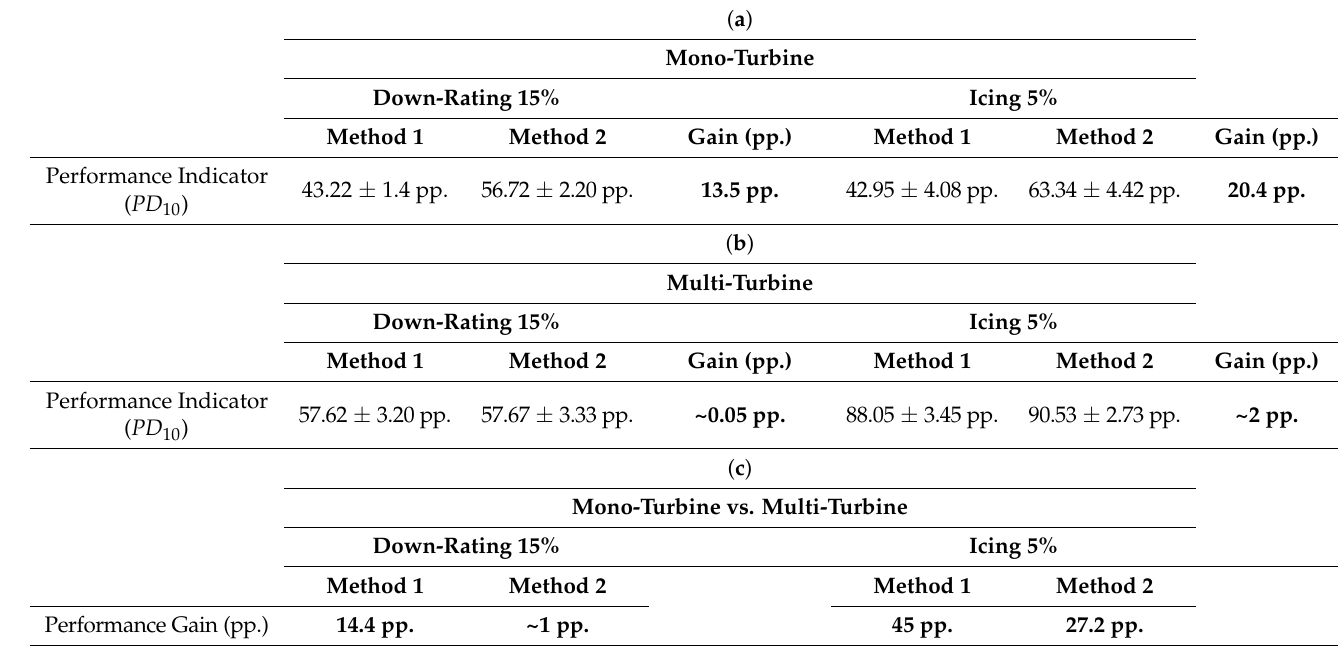
Table 2. ( a ). Performance comparison of Method 1 vs Method 2— Mono-Turbine config . ( b ). Per- formance comparison of Method 1 vs Method 2— Multi-Turbine config . ( c ). Performance gain of Multi-Turbine over